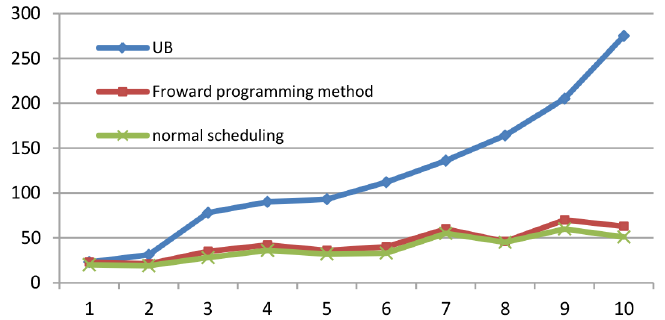
Figure 57. Comparing the makespan in normal scheduling and forward serial programming for the solved experiments